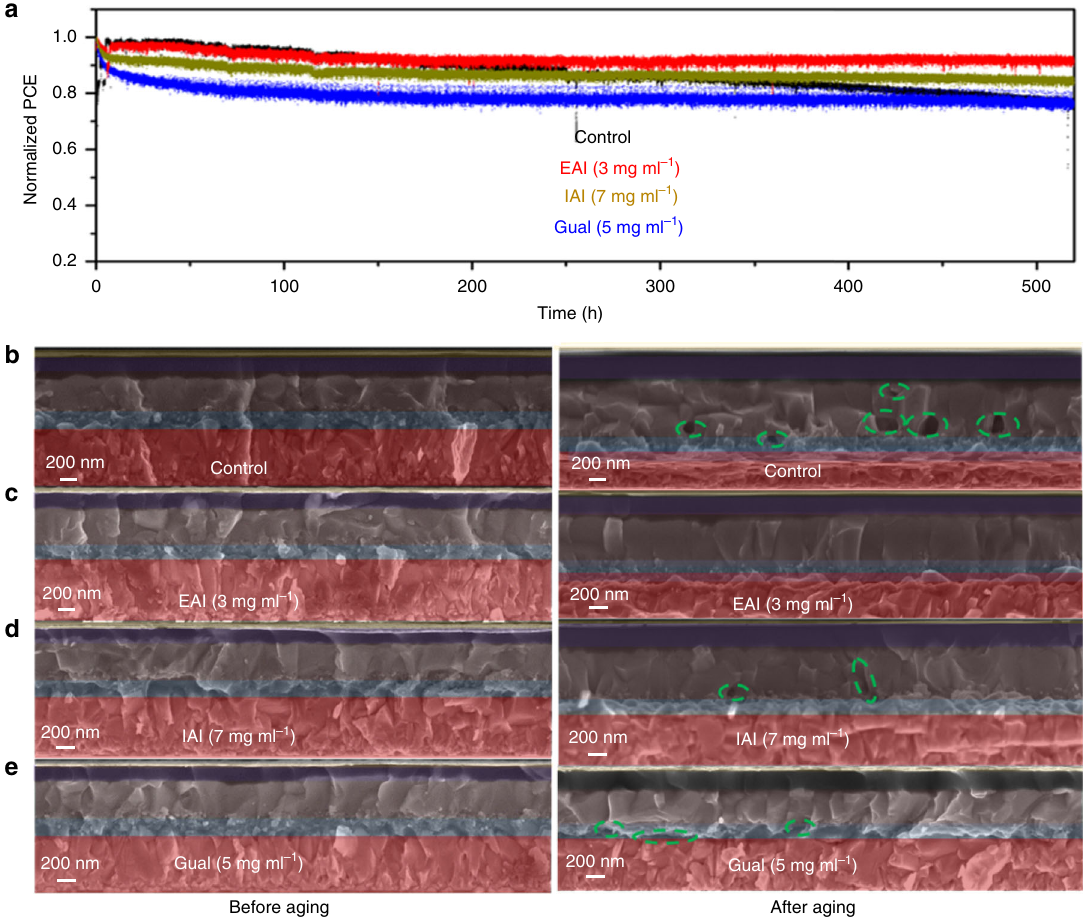
Fig. 6 Stability data and cross section before and after aging for control and treated devices: a A comparison of operational stability of control and treated perovskite devices. The devices were measured under a nitrogen environment at room temperature under constant illumination (LED source, ~1 Sun) at a maximum power point for 550 h. b , c , d , e Cross-sectional SEM images of the control and modi fi ed perovskite devices before and after aging at room temperature under constant illumination (LED source, ~1 Sun) for 550 h. Images show perovskite absorber and covering